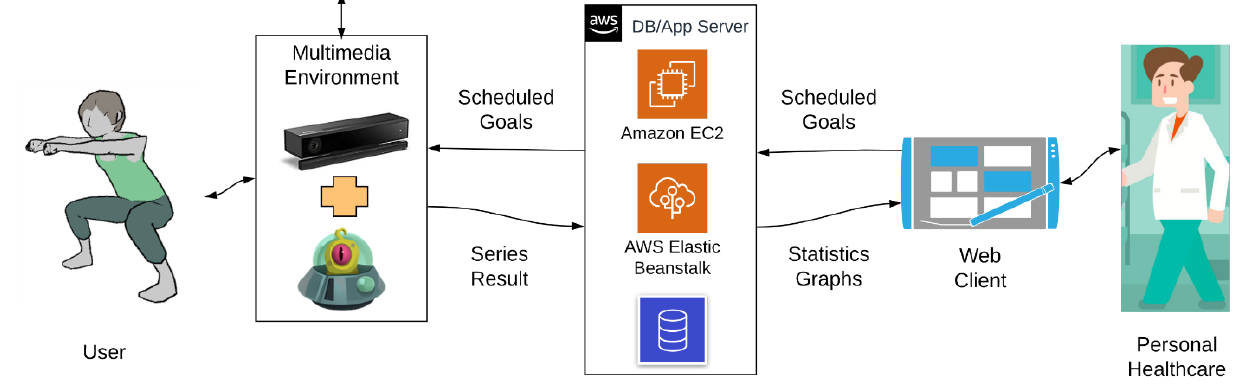
Figure 1. KineActiv system architecture [25].